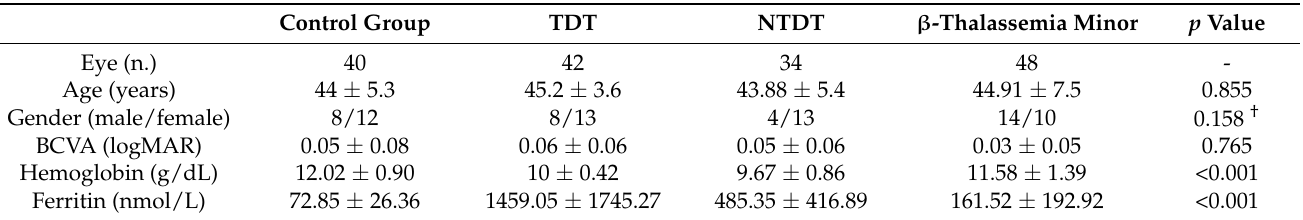
Table 1. Demographic, ophthalmologic and hematologic characteristics of controls and β -thalassemia patients. Control Group